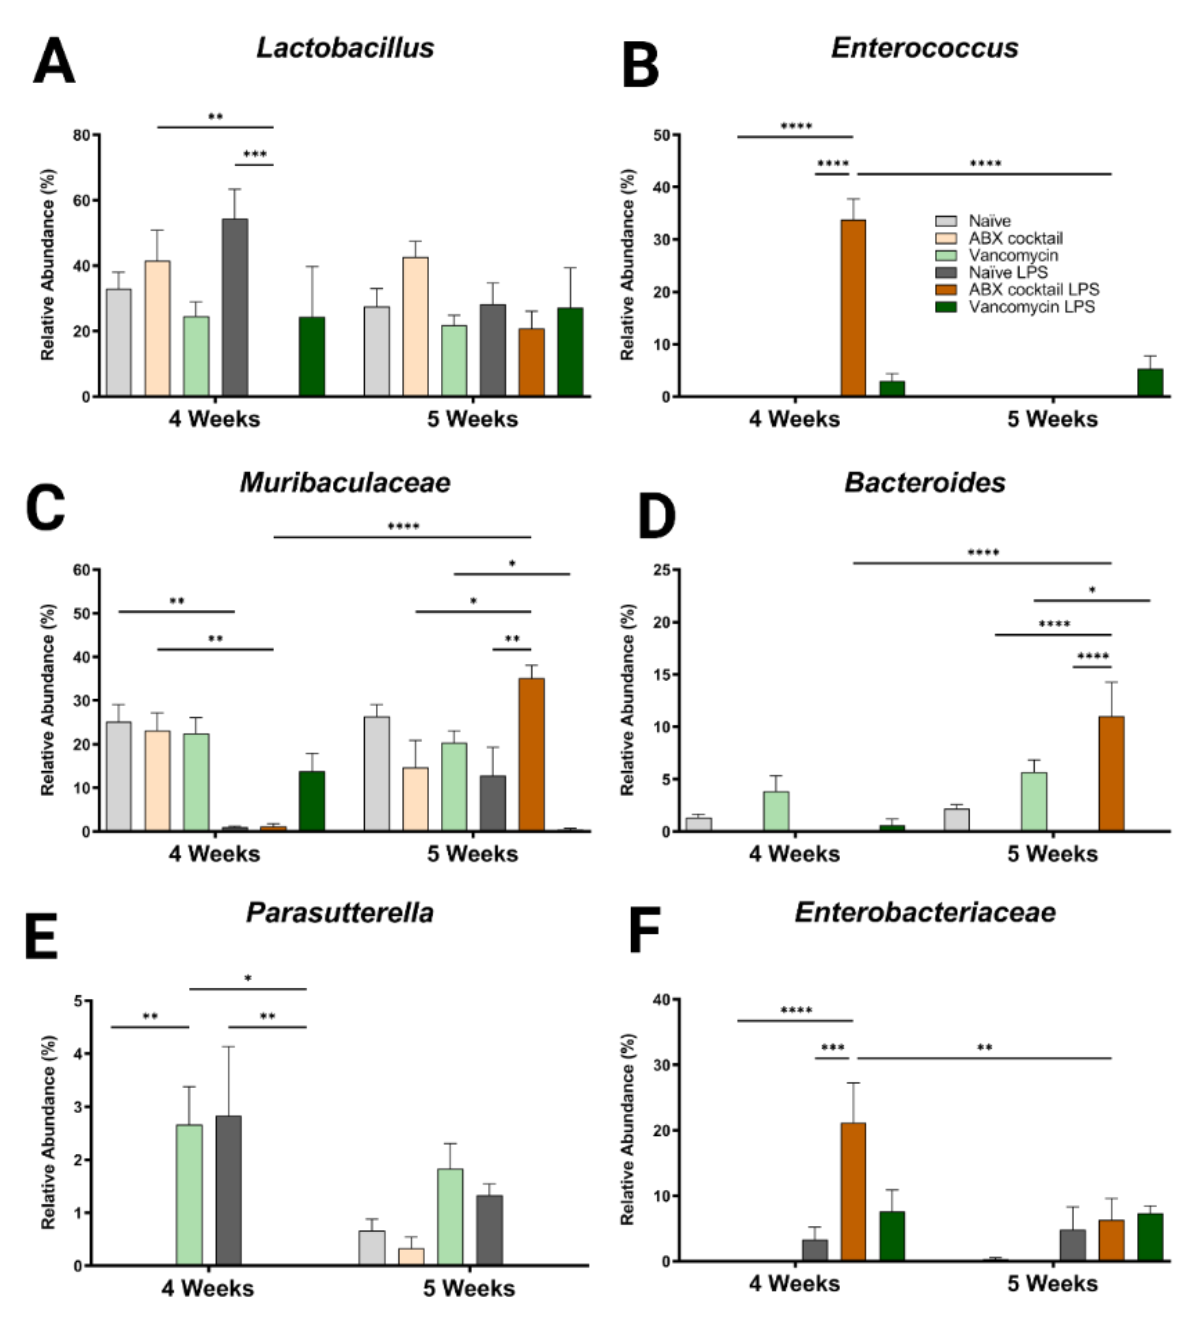
Figure 3. Maternal ABX alters offspring genus populations. Relative abundances of ( A ) Lactobacillus , ( B ) Enterococcus , ( C ) Muribaculaceae , ( D ) Bacteroides , ( E ) Parasutterella , and ( F ) Enterobacteriaceae at 4 and 5 weeks. Naïve = light grey, ABX cocktail = light brown, Vancomycin = light green, Naïve LPS = grey, ABX cocktail LPS = brown and Vancomycin LPS = green. n = 6 for all groups. Two-way ANOVA followed by Tukey post-correction test for multiple comparisons where values represent means ± SEM, * p ≤ 0.05, ** p ≤ 0.01, *** p ≤ 0.001 and **** p ≤ 0.0001.